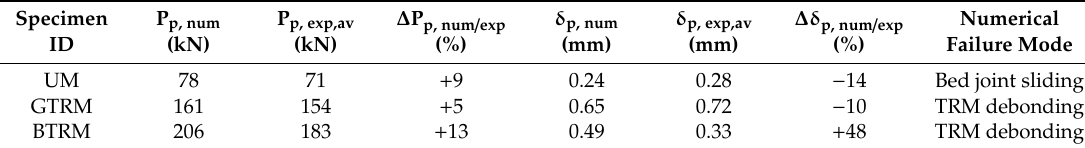
Table 13. Numerical results (peak load, peak displacement, failure mode) and comparison with the experimental values.